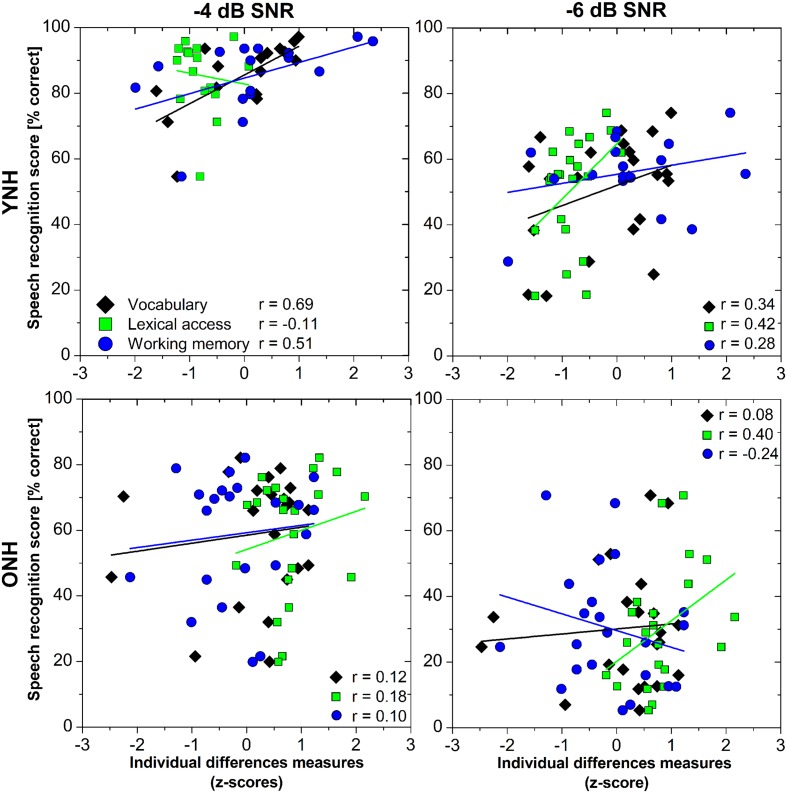
Pearson’s correlations of speech recognition scores and individual differences measures (vocabulary, lexical access, working memory) for younger (YNH, upper panels) and older (ONH, lower panels) listeners with normal hearing, and for SNRs of -4 (left column) and -6 (right column) dB.